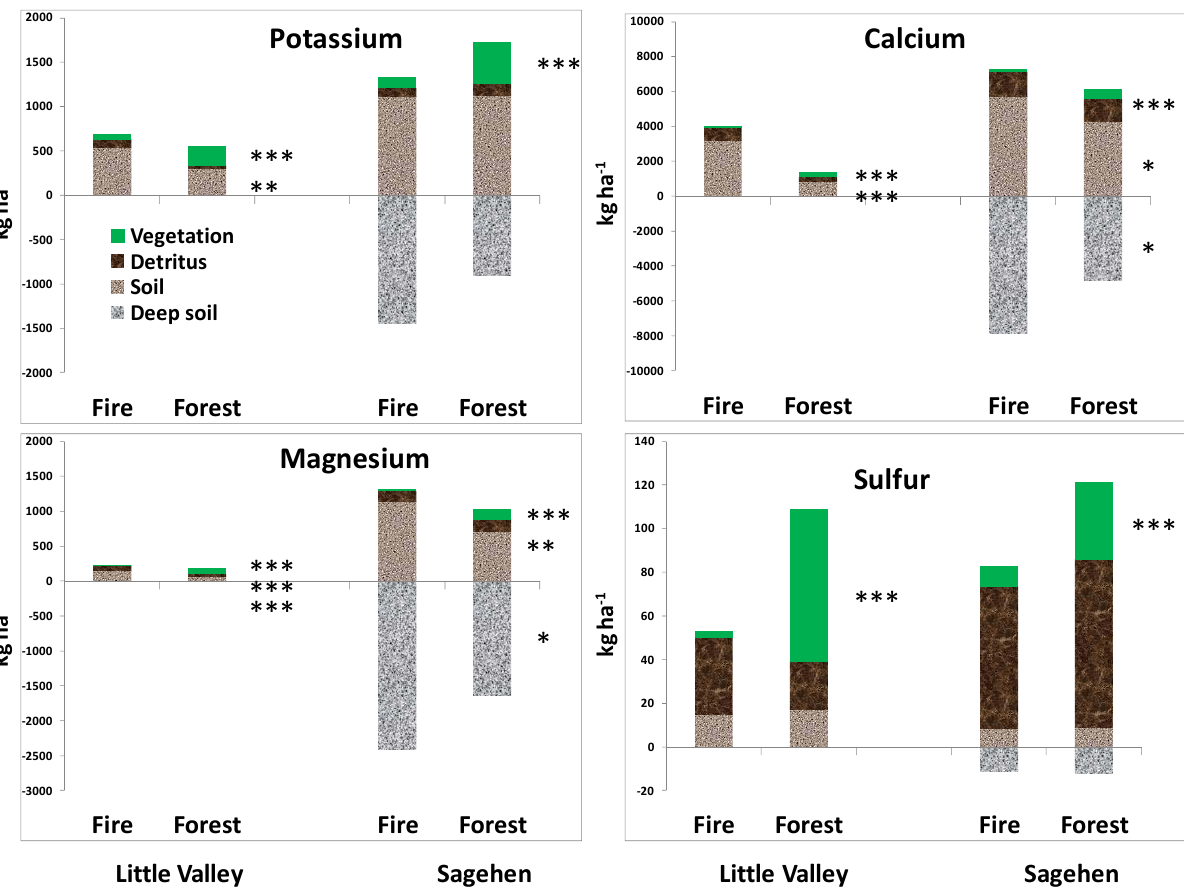
Figure 5. Potassium, calcium, magnesium and sulfur distribution in former fire and forest areas of the Sagehen site. Soil values for potassium, calcium, magnesium represent exchangeable values, and soil values for sulfur represent extractable SO 42 − . *, ** and *** indicate statistically significant differences in vegetation, O horizon, and soil content, respectively. For the Sagehen site, soil values to the 45 cm depth are shown for comparison with Little Valley and soil values to 95 cm are shown separately as negative numbers below the 0